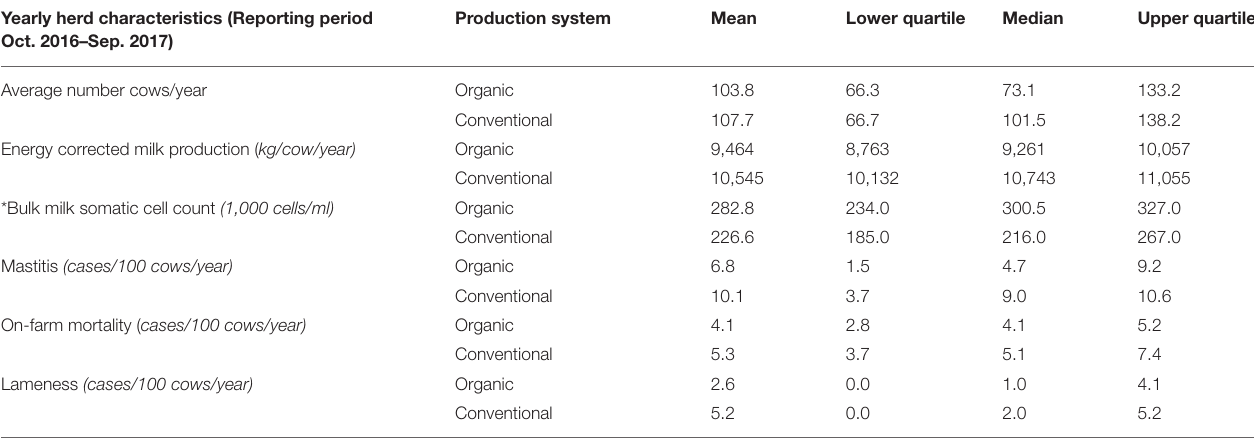
TABLE 1 | Yearly herd characteristics in a sample of 26 organic and 25 conventional Swedish dairy herds. Yearly herd characteristics (Reporting period Oct. 2016–Sep. 2017)